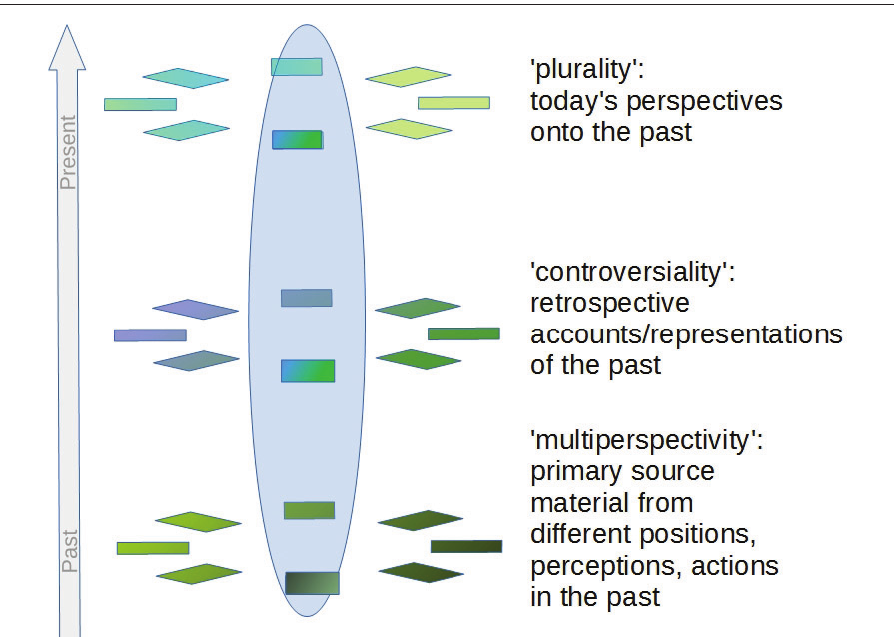
Figure 1: A transcultural model of multiperspectivity Neither of these orientations can stand alone. It is not a question of either/or, but of reflecting the interplay of a set of cultural dimensions, dividing and joining us at the same time. References to common features and experiences today may not overrule any recognition of ancestors’ experiences or deeds as one’s ‘own’. Neither should identification with one’s ancestors hinder recognition of, and reflection on, common features and experiences in an emerging global world characterized by both continuity and change.